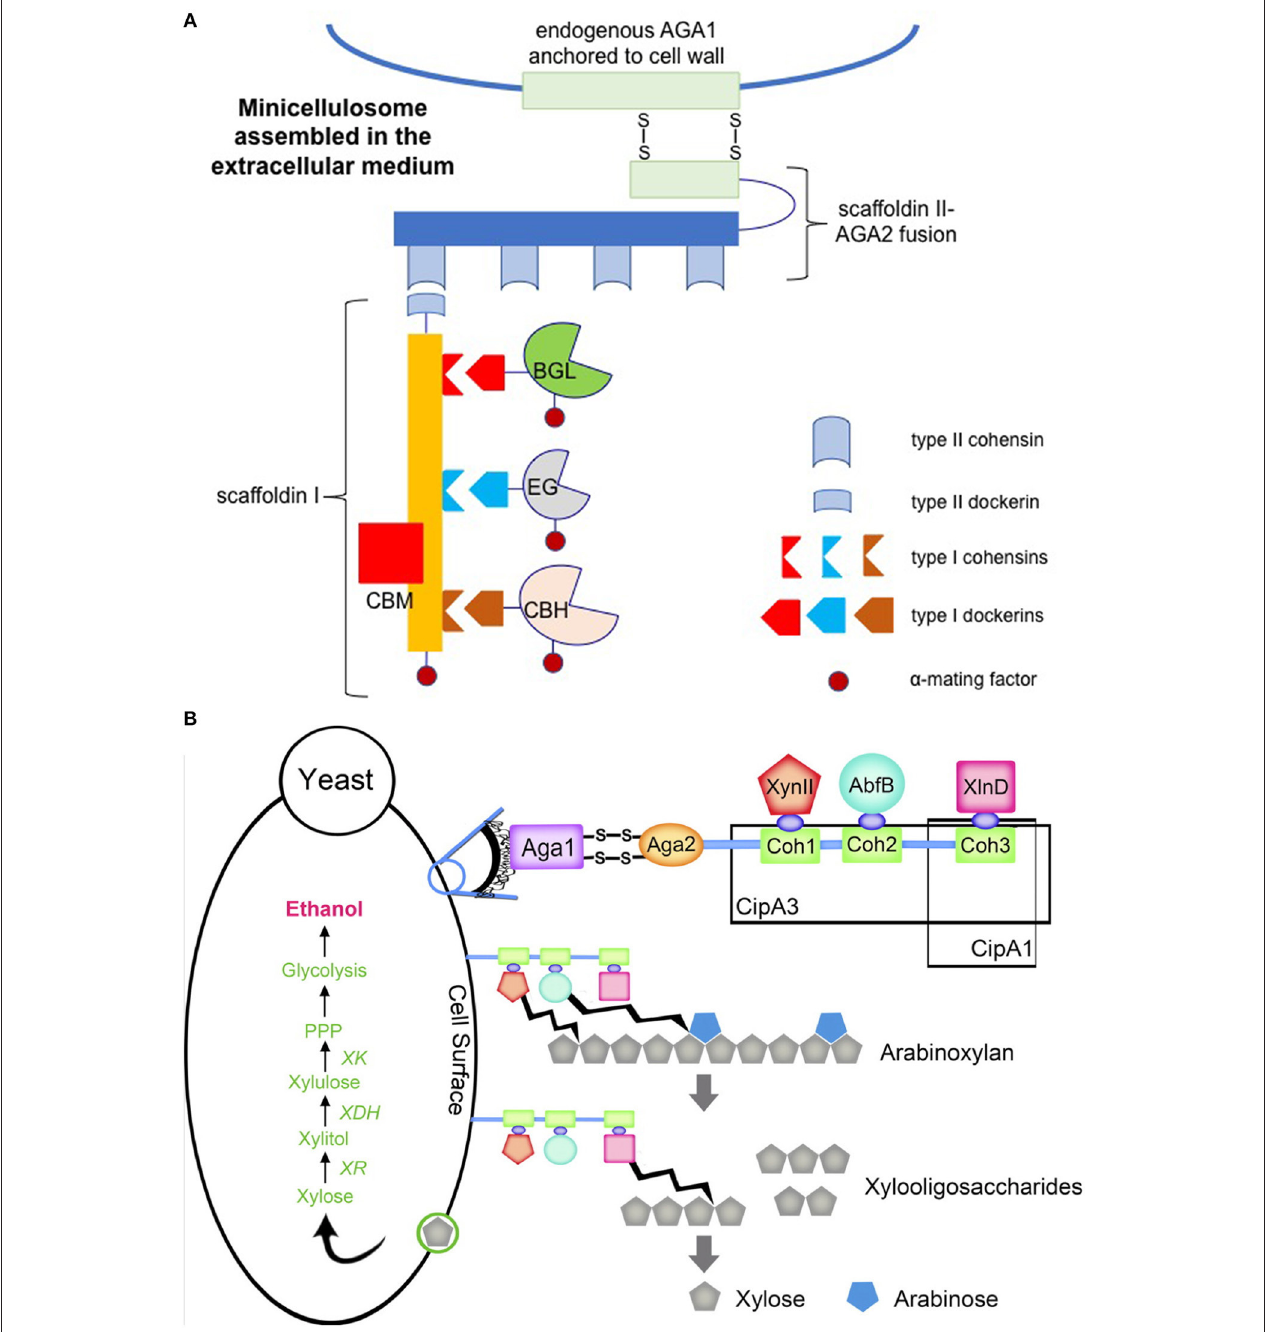
FIGURE 4 | Engineered cellulosome (A) and hemicellulosome (B) in S. cerevisiae . (A) Three cellulases from Clostridia were heterologously expressed in S. cerevisiae , including endoglucanase (EG), cellobiohydrolase (CBH), and β -glucosidase (BGL). Each cellulase contained a type I dockerin specific to one of three type I cohesins present on scaffoldin I which was expressed by the recombinant strain. Fusion of these four components to α -mating factor enabled secretion to the extracellular medium to prevent intracellular assembly. Expression of a scaffoldin II-a-agglutinin adhesion subunit (AGA2) fusion tethered scaffoldin I-cellulase complexes to the cell wall via type II dockerin-cohesin interactions. Scaffoldin II-AGA2 anchored to the cell wall via formation of two disulfide bridges between AGA2 and endogenous a-agglutinin anchorage subunit (AGA1). The image was prepared according to the previous study carried out by Fan et al. (2012) (B) Minihemicellulosomes were expressed in S. cerevisiae carrying the xylose utilizing pathway. The miniscaffoldin CipA1 contained one type I cohesion (Coh3), whereas the miniscaffoldin CipA3 contained three type I cohesions (Coh1, Coh2, and Coh3). Each miniscaffoldin was tethered to the cell wall via AGA1 and AGA2 interaction, analogous to the cellulosome structure in (A) . The endoxylanase (XynII), arabinofuranosidase (AbfB), and β -xylosidase (XlnD) were tethered to the miniscaffolidns via type 1 dockerin-cohesin interactions. The original figure published in Sun et al. (2012) was shown here with a copyright permission.